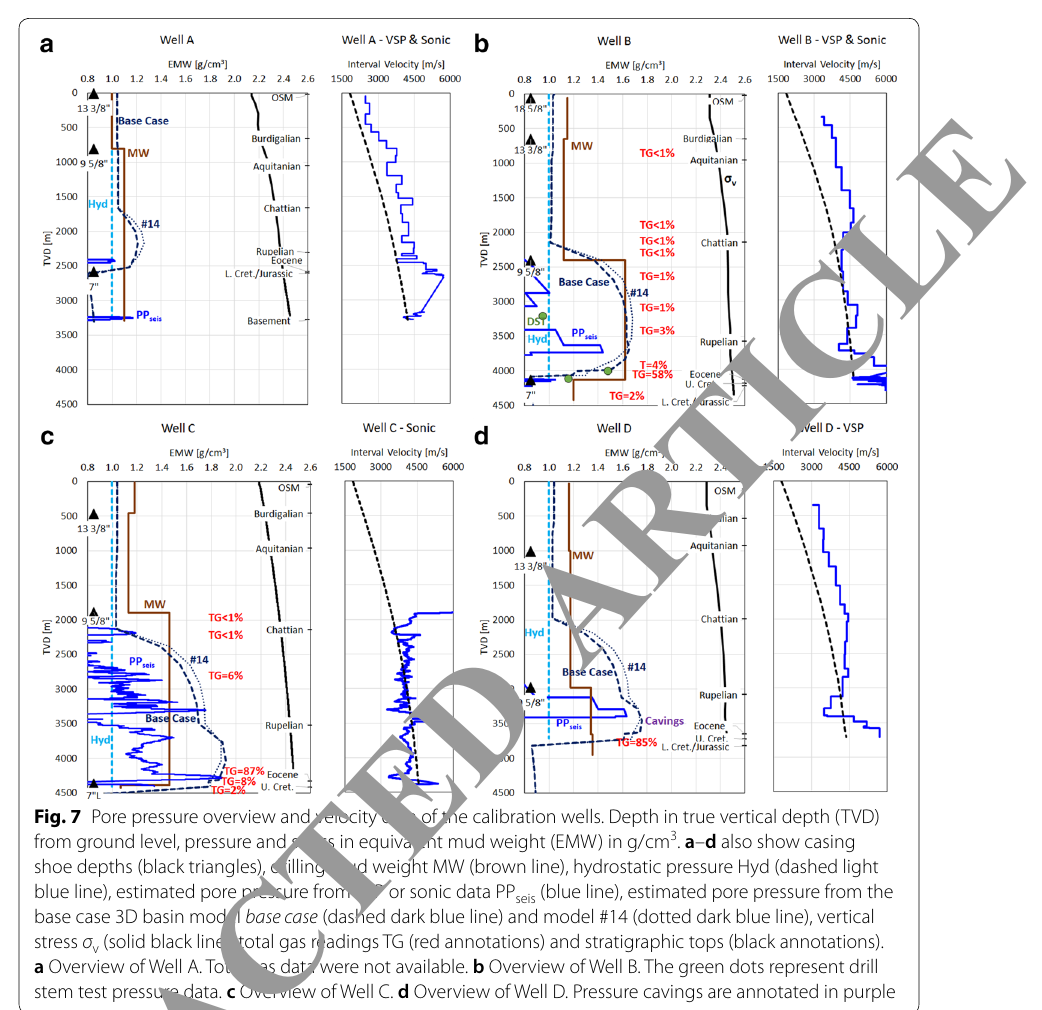
Fig. 7 Pore pressure overview and velocity data of the calibration wells. Depth in true vertical depth (TVD) from ground level, pressure and stress in equivalent mud weight (EMW) in g/cm 3 . a – d also show casing shoe depths (black triangles), drilling mud weight MW (brown line), hydrostatic pressure Hyd (dashed light blue line), estimated pore pressure from VSP or sonic data PP seis (blue line), estimated pore pressure from the base case 3D basin model base case (dashed dark blue line) and model #14 (dotted dark blue line), vertical stress σ v (solid black line), total gas readings TG (red annotations) and stratigraphic tops (black annotations). a Overview of Well A. Total gas data were not available. b Overview of Well B. The green dots represent drill stem test pressure data. c Overview of Well C. d Overview of Well D. Pressure cavings are annotated in